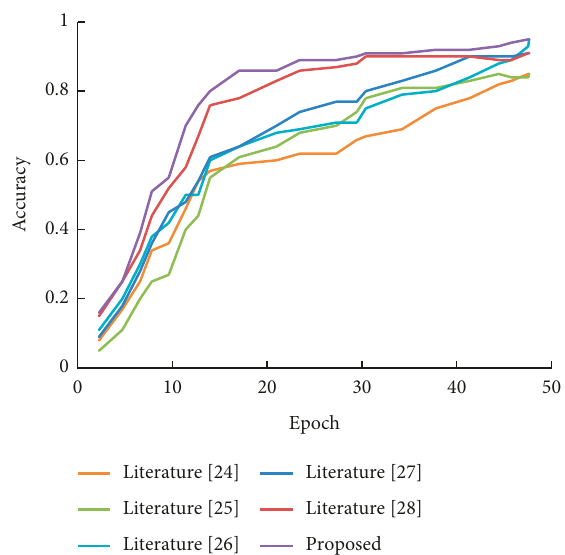
Figure 7: NTU-RGB +D 120 data set training result graph: accuracy.